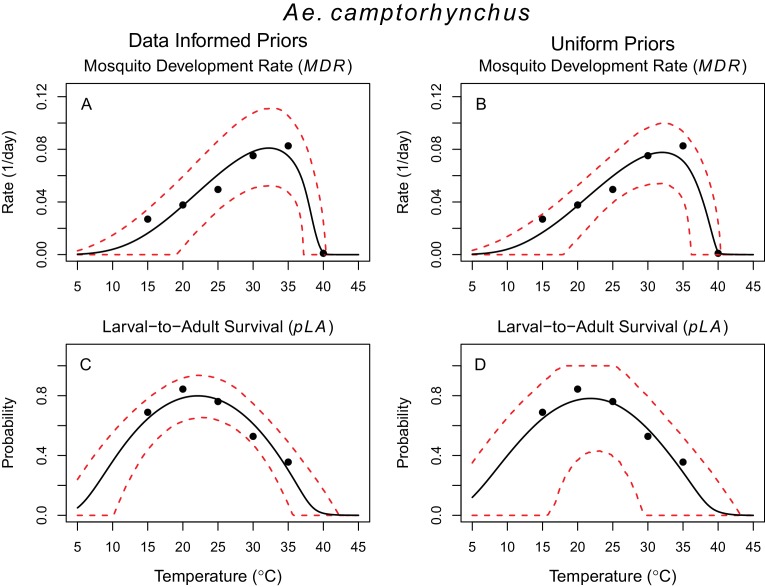
Thermal responses of Ae. camptorhynchus.10.7554/eLife.37762.008Figure 2—figure supplement 2—source data 1.Trait thermal response functions and data sources for Murray Valley Encephalitis virus and additional vector species (Ae. notoscriptus and Ae. camptorhynchus).‘Par.’=model parameter. Results are given for fits from data-informed priors. Asymmetrical responses fit with Brière function (B): B(T)= qT(T – Tmin)(Tmax
– T)1/2; symmetrical responses fit with quadratic function (Q): Q(T) = -q(T – Tmin)(T – Tmax). Function coefficients (and 95% credible intervals) fit via Bayesian inference. This table also includes source data for Figure 2—figure supplement 3 and Figure 2—figure supplement 4.